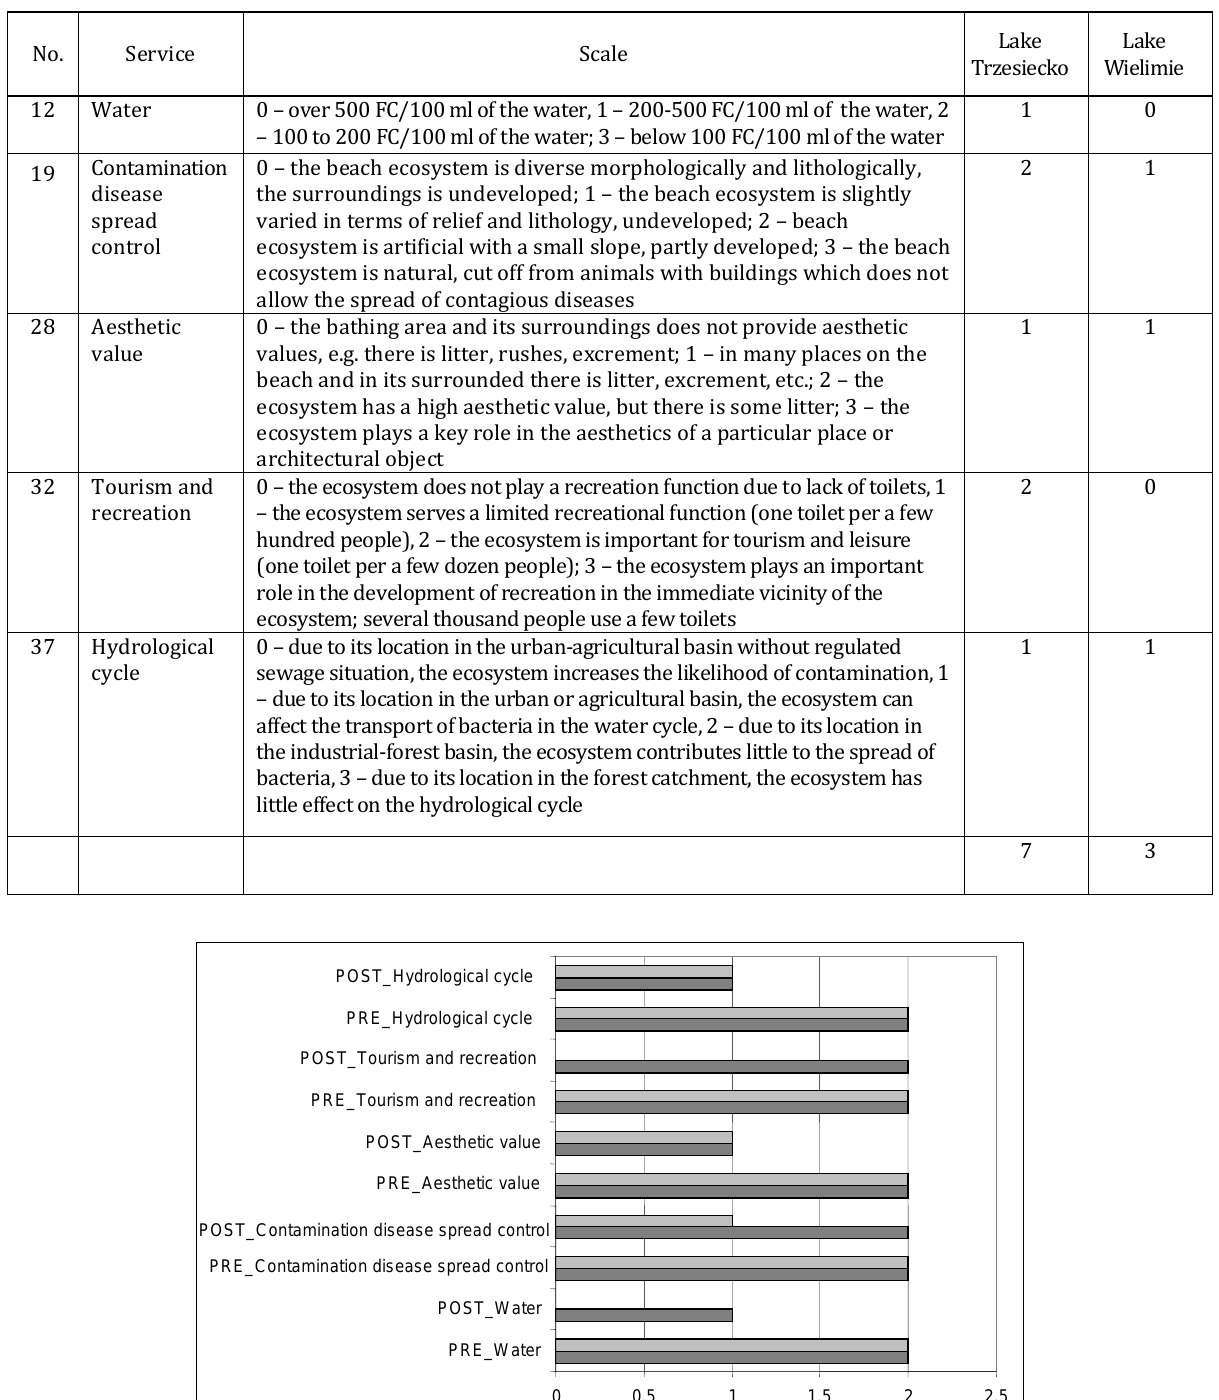
Table 4. Proposal of post-valuation of services of the ecosystems of Lakes Trzesiecko and Wielimie on the basis of the results of bacteriological contamination No. Service Scale